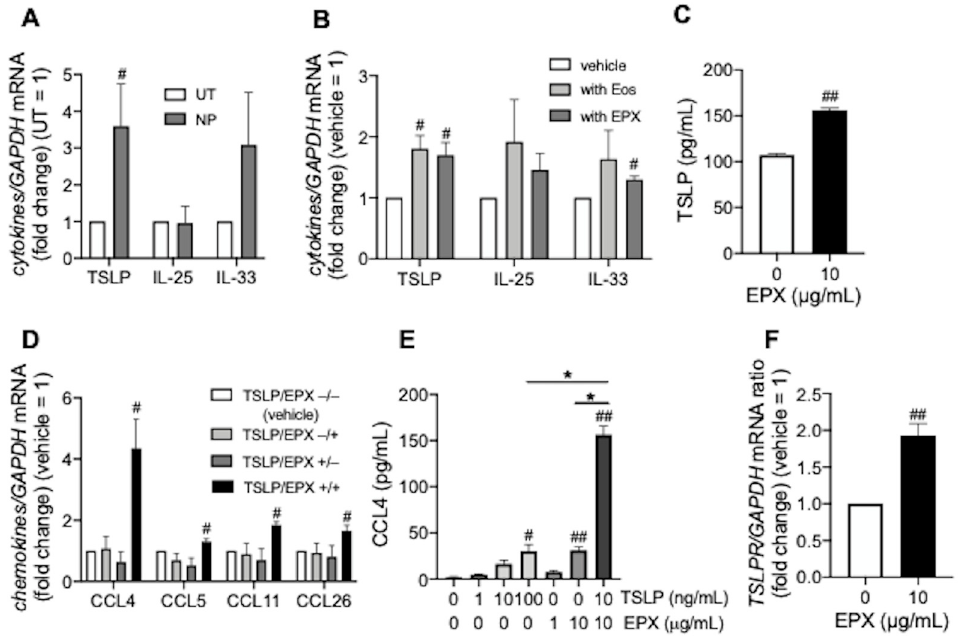
Figure 1. Epithelial cell-derived cytokines and chemokines levels during eosinophilic inflammation. ( A , B ) Innate immune response-associated cytokine mRNA in nasal polyps from patients with ECRS ( A ) and BEAS-2B cells co-incubated overnight with purified peripheral blood eosinophils or recombinant eosinophil peroxidase (EPX, 10 µg/mL) for 72 h ( B ). ( C ) TSLP release from BEAS-2B cells incubated with EPX for 48 h. ( D , E ) Eosinophil-recruiting chemokines in BEAS-2B cells incubated with TSLP (10 ng/mL) for 48 h, followed by overnight stimulation with EPX (10 µg/mL). CCL4, CCL5, CCL11, and CCL26 mRNA levels ( D ) and CCL4 release ( E ) were evaluated. ( F ) TSLP receptor (TSLPR) mRNA levels in BEAS-2B cells co-incubated with EPX for 48 h. Values in (( A , B , D , F ) repre- sent ratios to control (uncinate process tissue; UT from the same patients or non-treatment; vehicle) and values in all panels represent the mean ± standard error of the mean from four experiments; # p < 0.05, ## p < 0.01 (vs. UT or vehicle), * p < 0.05 (as shown between the two groups). 3.2. TSLP Enhances TLR3 Ligand-Mediated CCL4 Release Next, we examined innate immune reactions during CCL4 release from BEAS-2B cells. Among TLR2 ligand zymosan, TLR3 ligand poly I:C, TLR4 ligand LPS, TLR7 ligand imiquimod, and PAR2 agonist 2-Furoyl-LIGRLO-amide, poly I:C significantly increased CCL4 release from BEAS-2B cells (Figure 2A), which was enhanced by TSLP (Figure 2B), possibly via upregulated TLR3 expression which was further strengthened by EPX (Fig- ure 2C). Taken together, CCL4 may be associated with innate immune responses during eosinophilic inflammation.